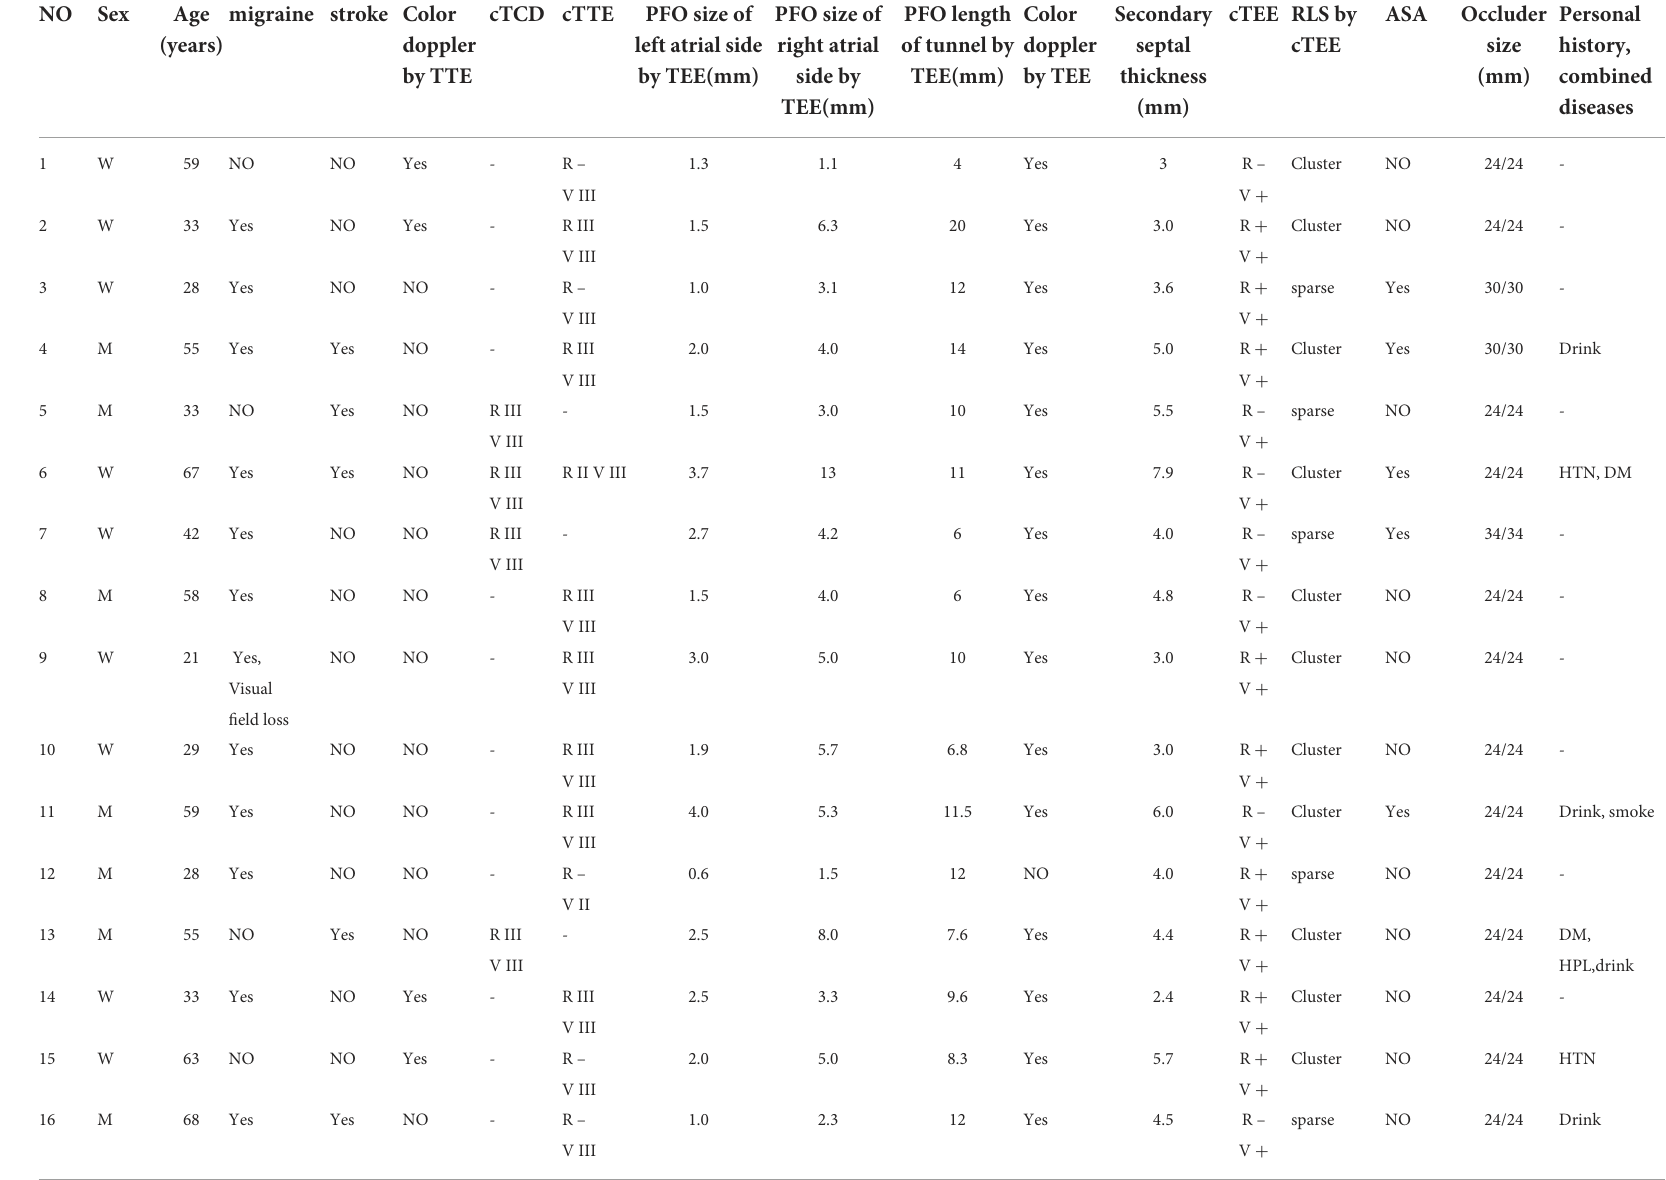
TABLE 1 Baseline demographic characteristics of the study